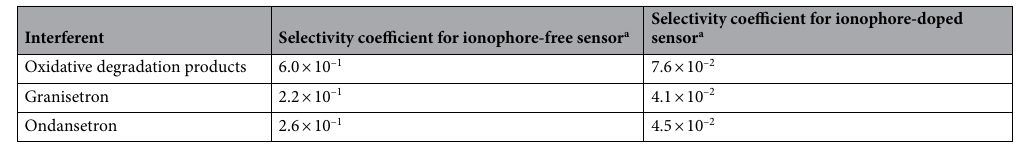
pot PALO,Int ) for the investigated PALO sensors using the separate